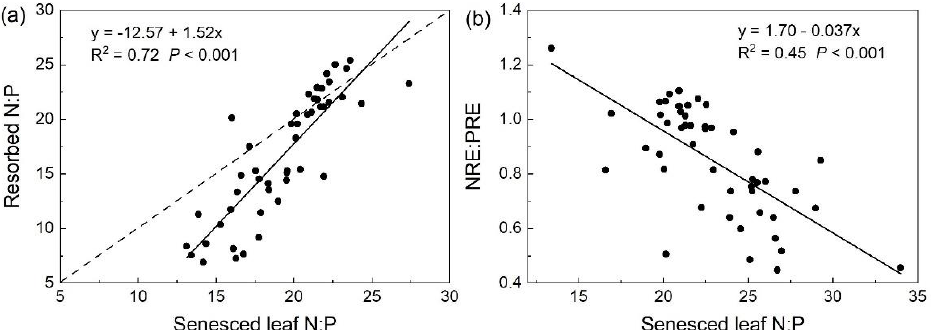
Figure 6. Relationship between senesced leaf N:P ratios and resorbed N:P ratios ( a ) and NRE:PRE ratios ( b ). The dash line represents the 1:1 line.